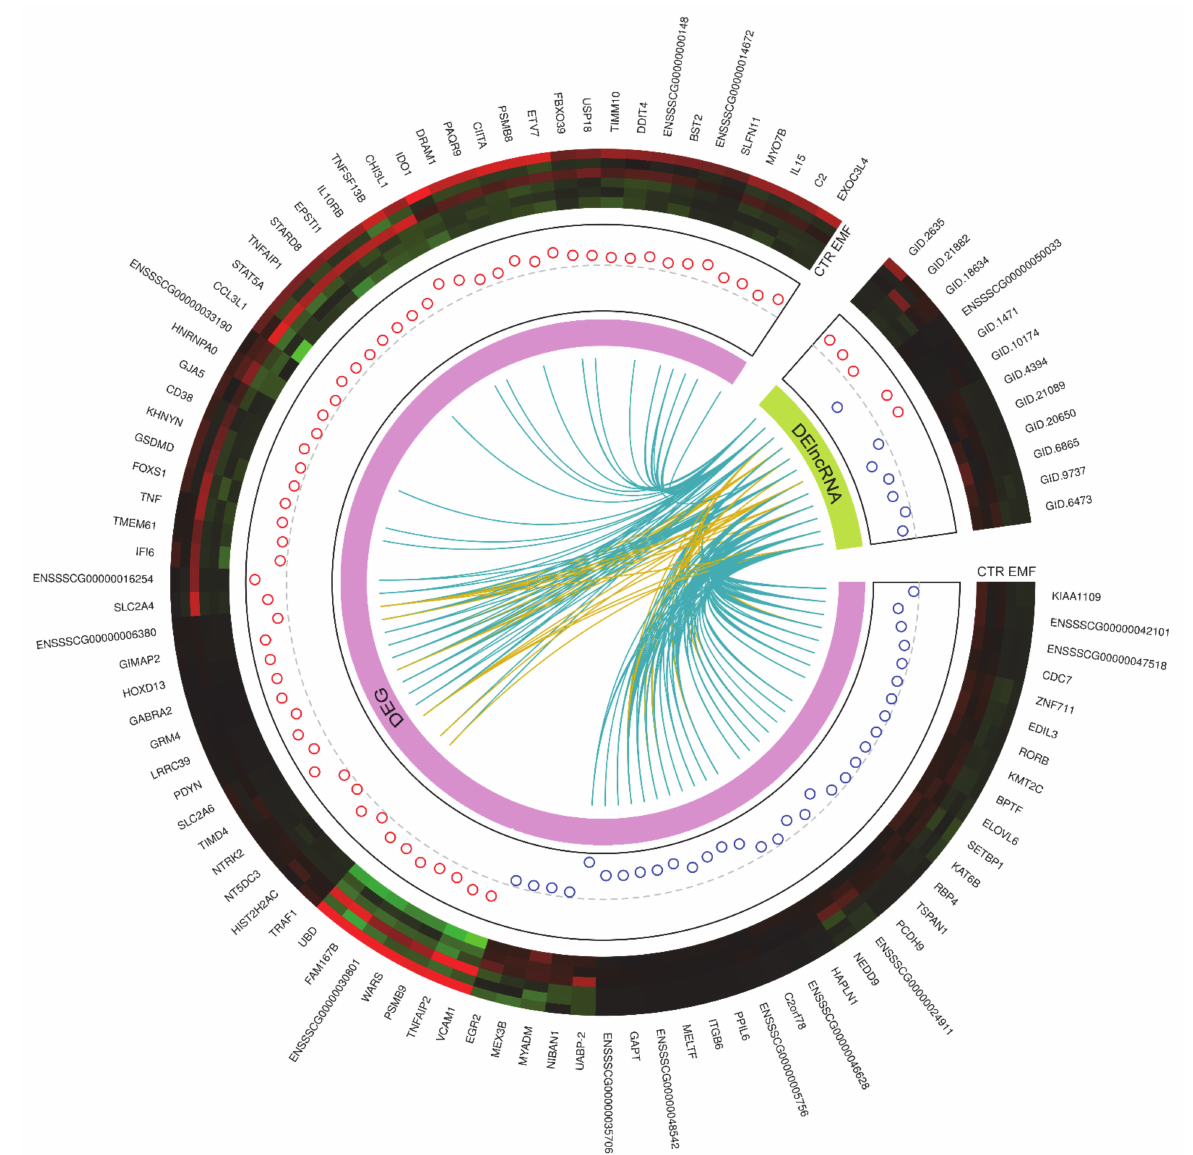
Figure 2. Visualization of differentially expressed genes (DEGs) and long noncoding RNAs (DE-lncRNAs) statistically significant (P-adjust < 0.05) in the impact of the electromagnetic field. The external circle represents the gene ID (gene names, ENSEMBL ID, StringTie ID) of DEGs (large part) and DE-lncRNAs (small part). Six upper tracks depict the normalized (Z-score; red-green scale) expression values for DEGs and DE-lncRNAs in each RNA-seq library. The circles in the next track describe increased (red) and decreased (blue) expression (logFC) in the compared groups. The next track shows the links between the correlated DEGs and DE-lncRNAs, where blue links depict positive correlation and yellow negative. Figure created with circlize Bioconductor library and custom R